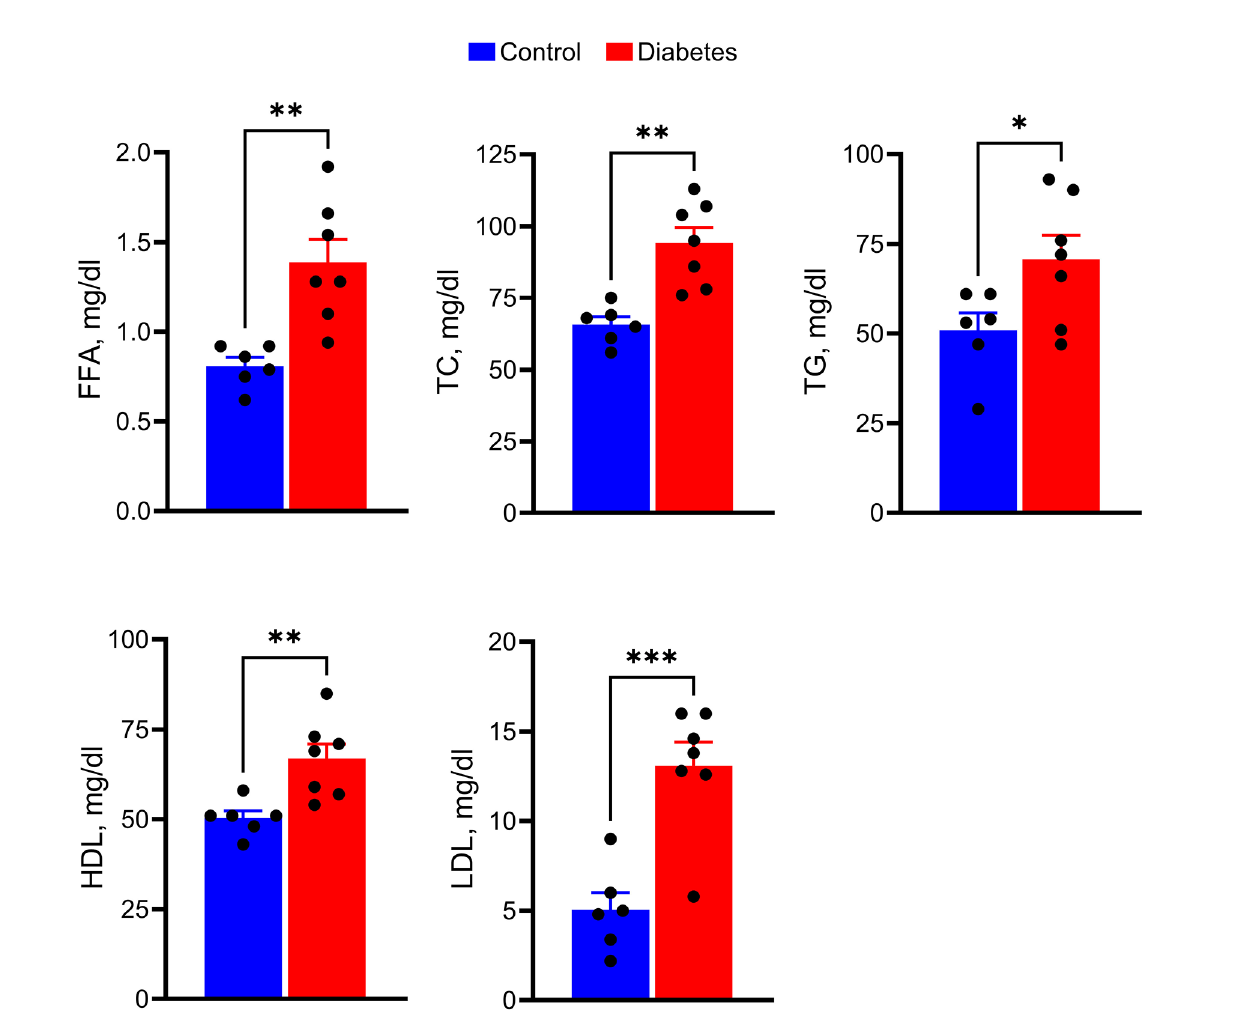
FIGURE 2 | Hyperglycemic tree shrews undergo changes in the levels of serum parameters such as FFA, TC, TG, HDL, and LDL. * p < 0.05, ** p < 0.01, *** p < 0.001, (n=